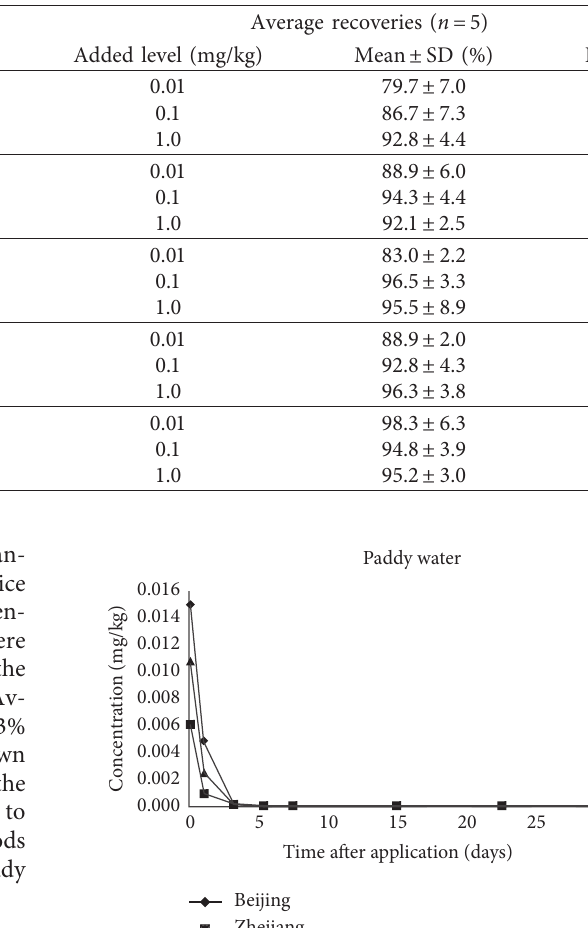
Table 3: LODs, LOQs, and average recoveries of indoxacarb in five matrices.